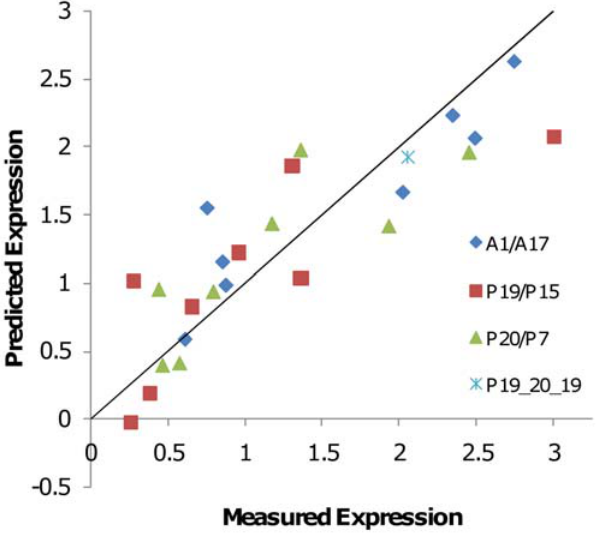
Figure 5. Prediction of variant chimera expression by the combined dataset PLS model. Expression predicted by the combined model shown in Figure 2C for the subset of chimeric variants. Each chimera series is indicated by different symbols as shown in the legend.